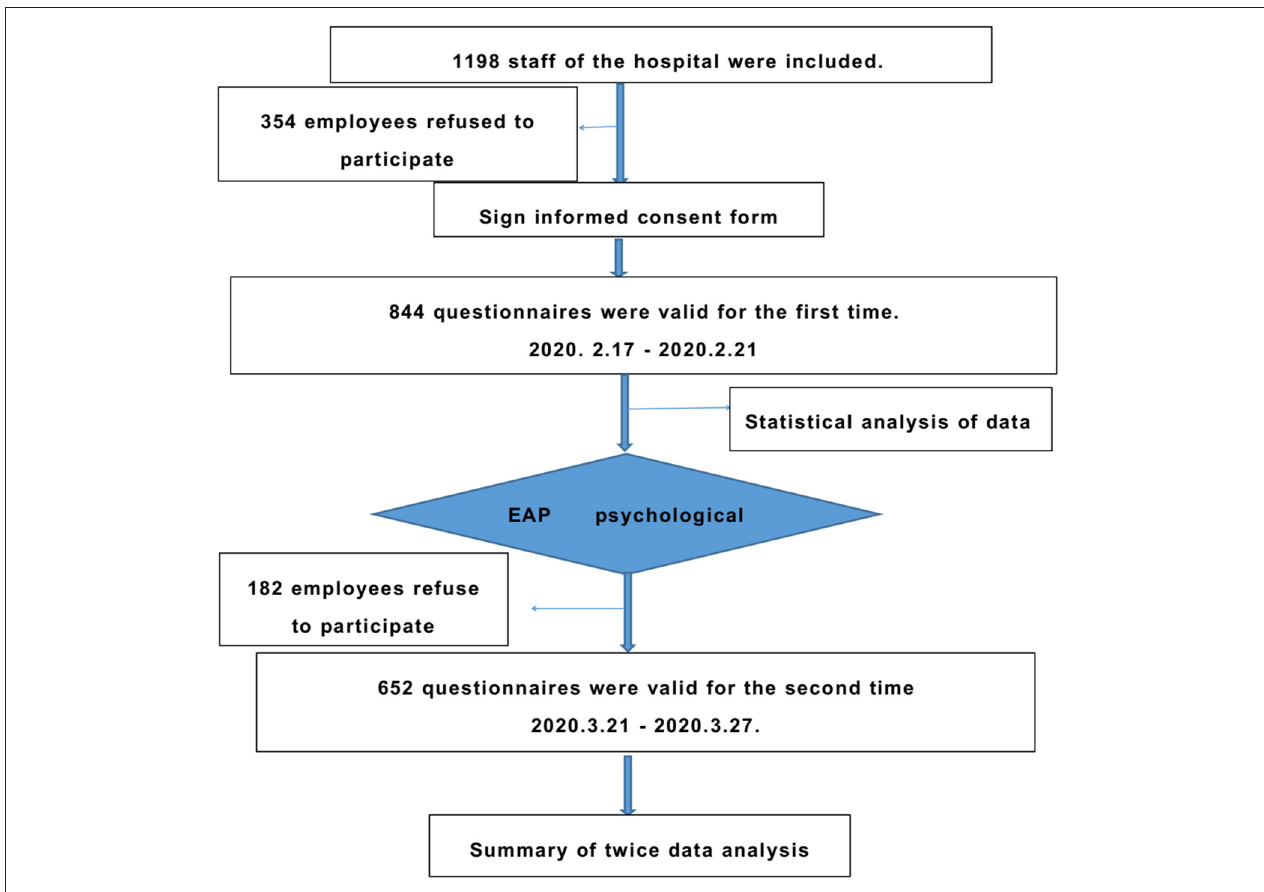
FIGURE 1 | Research design flowchart.